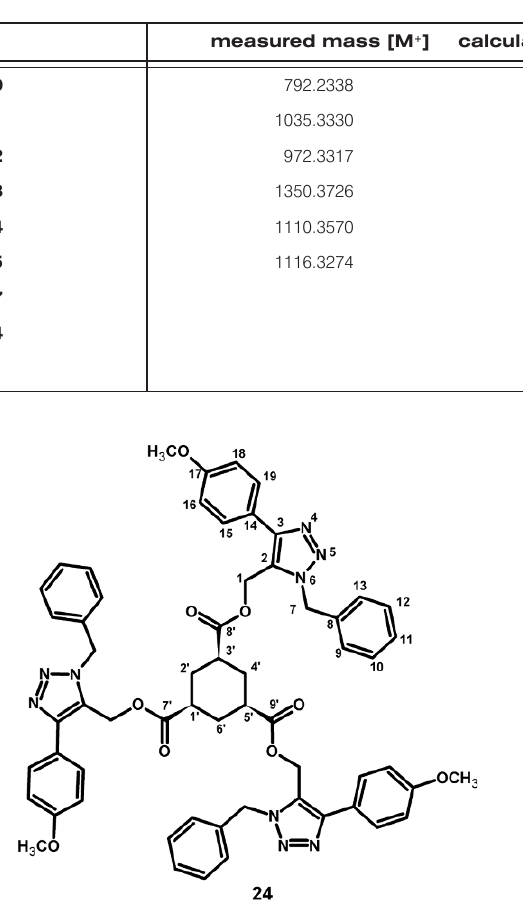
Table 2. Conversion rates in MeCN-H Ligand (0.02 equiv.)